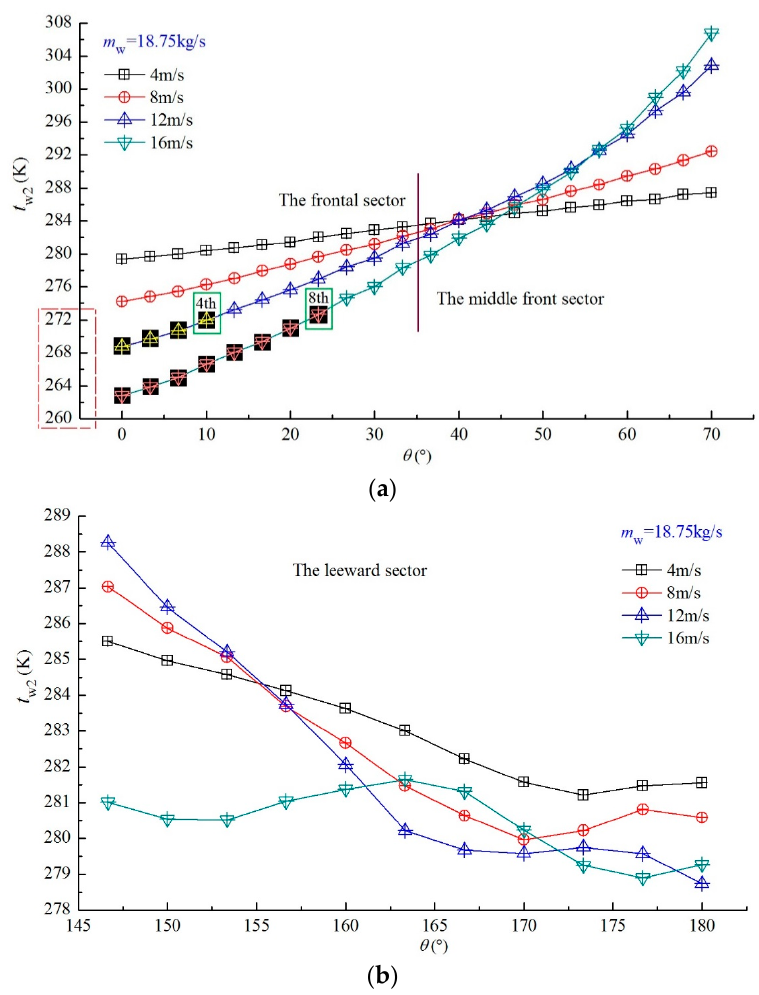
Figure 11. Outlet water temperature of each delta with 50% water flow rate increase. ( a ) In frontal and middle front sectors; ( b ) in rear sector.